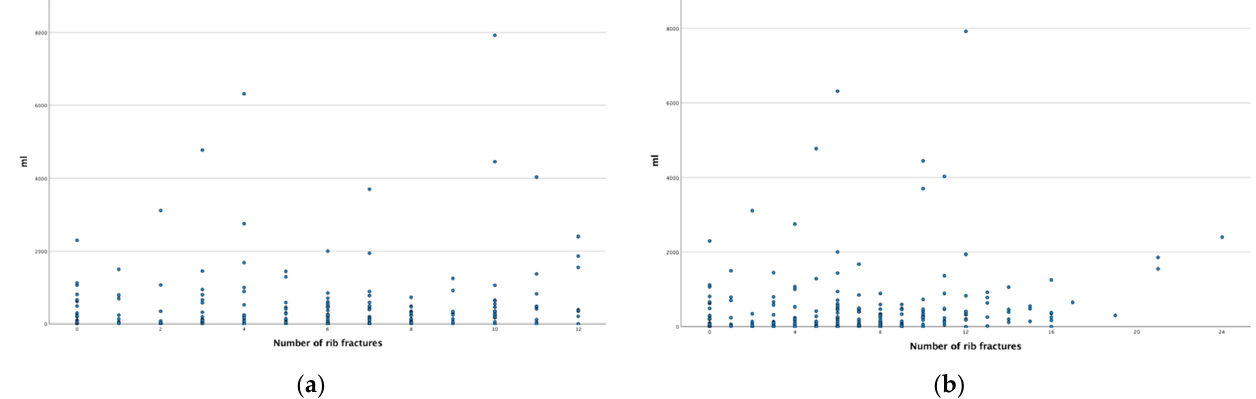
Figure 6. Scatter plot showing the relationship between the highest number of rib fractures on one side ( a ) and both sides ( b ) on one side with chest-tube output in